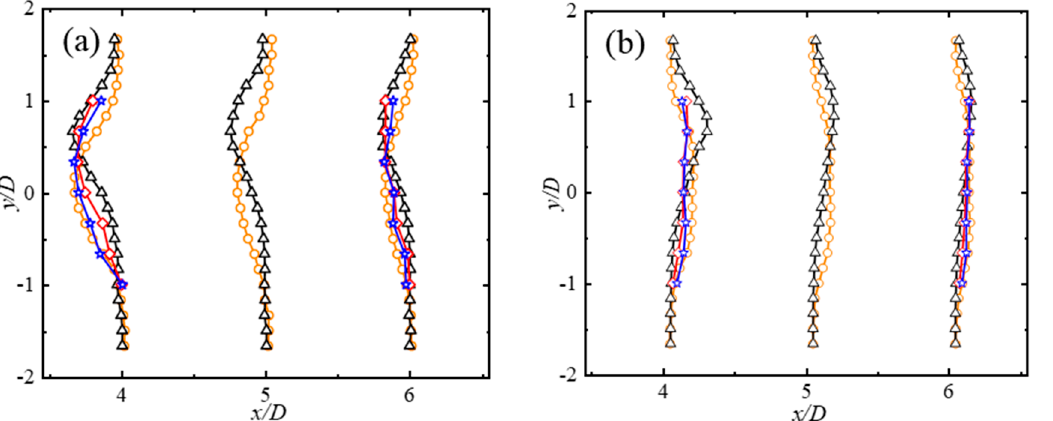
Figure 11. Comparisons of the wake characteristics with different yaw angles ( U 06- Iu 06- γ 00- Opt—orange dotted lines; U 06- Iu 06- γ 10-Opt—red diamond dotted lines; U 06- Iu 06- γ 20-Opt—blue star dotted lines; U 06- Iu 06- γ 30-Opt—black rhomb lines). ( a ) Normalized mean velocity profile; ( b ) turbulence intensity profile.